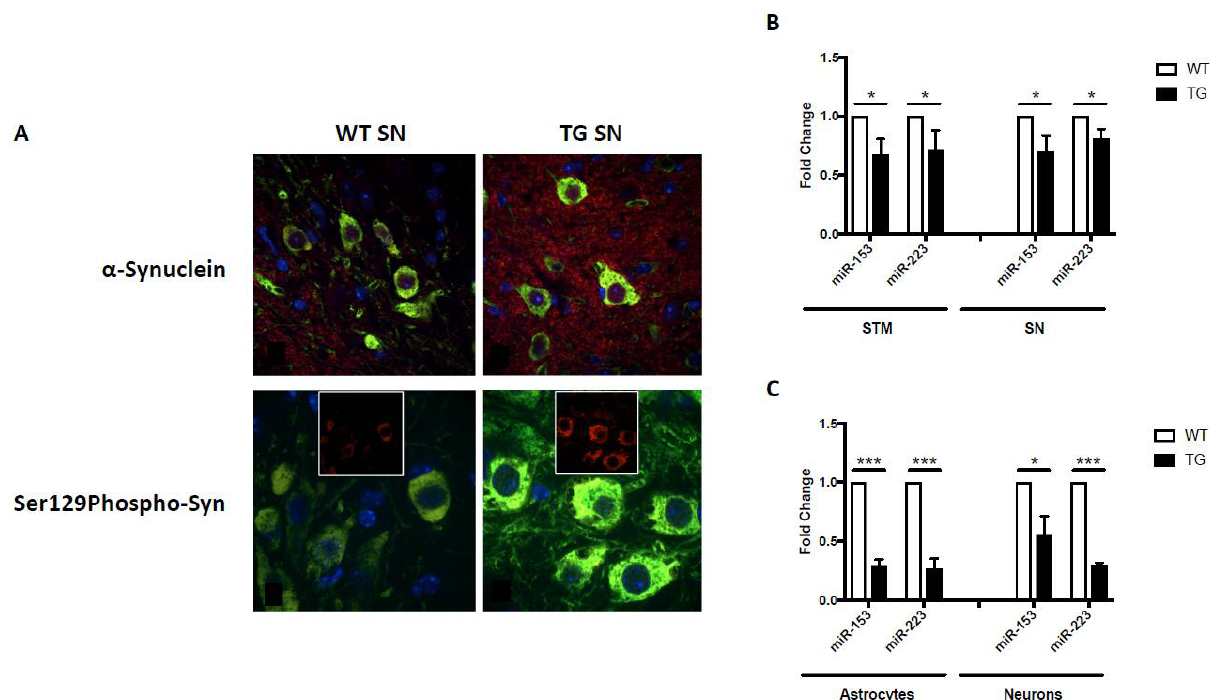
Figure 2. α -Synuclein expression and miRNA regulation in GFAP.HMOX1 mice. ( A ) Confocal imaging of intra- and extraperikaryal α -synuclein (red) and Ser129-phosphorylated (S129Phospho) α -synuclein (red) immunofluorescence in dopaminergic neurons of the substantia nigra (SN). TH (green) and DAPI (blue) in 19-month-old WT and transgenic substantia nigra. ( B ) Downregulation of miR-153 and miR-223 in transgenic substantia nigra (SN) and striatum (STM) in vivo and ( C ) transgenic primary astrocyte–neuronal co-cultures. All data were obtained via RT-qPCR and analyzed using the ∆∆ Ct method relative to internal and endogenous controls. n = 5; * p < 0.05; *** p < 0.001. (From [64], with permission).